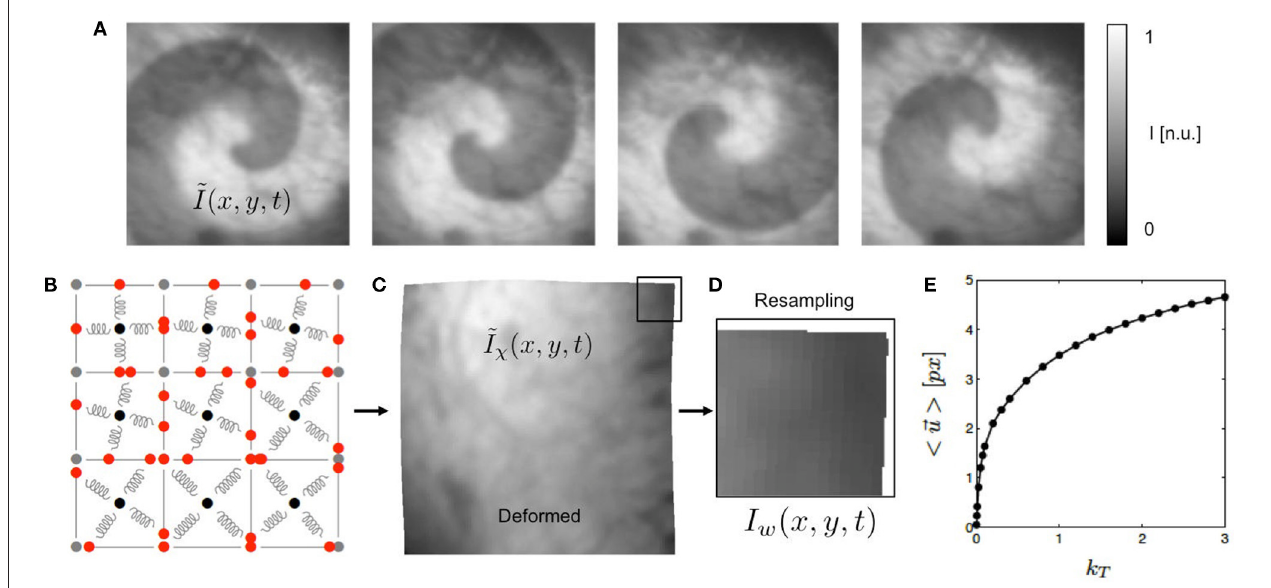
FIGURE 2 | Generation of synthetic optical maps using computer simulations. (A) Original optical mapping image (100 × 100 pixels) cropped from video still frame showing heart surface of rabbit heart superimposed by simulated spiral wave pattern (exaggerated) generated using reaction-diffusion excitable dynamics model. Simulated fluorescence intensity drop during depolarization of action potential (exaggerated). (B) Deformable elastic medium simulated with mass-spring damper lattice model (here consisting of only 3 × 3 cells for illustration purposes, system used in study consists of 100 × 100 cells). Each pixel in (A) corresponds to one cell. (C) Deformed video image ˜ I χ ( x , y ) containing fluorescent signal ( 1 F / F < 5 % , not visible in a still frame), deformation caused by spiral dynamics. See also Supplementary Video 3 . (D) Deformed and resampled part of video image I ( x , y ). (E) Overall displacements of simulation in pixels depending on simulation parameter k T to modulate contraction strength of